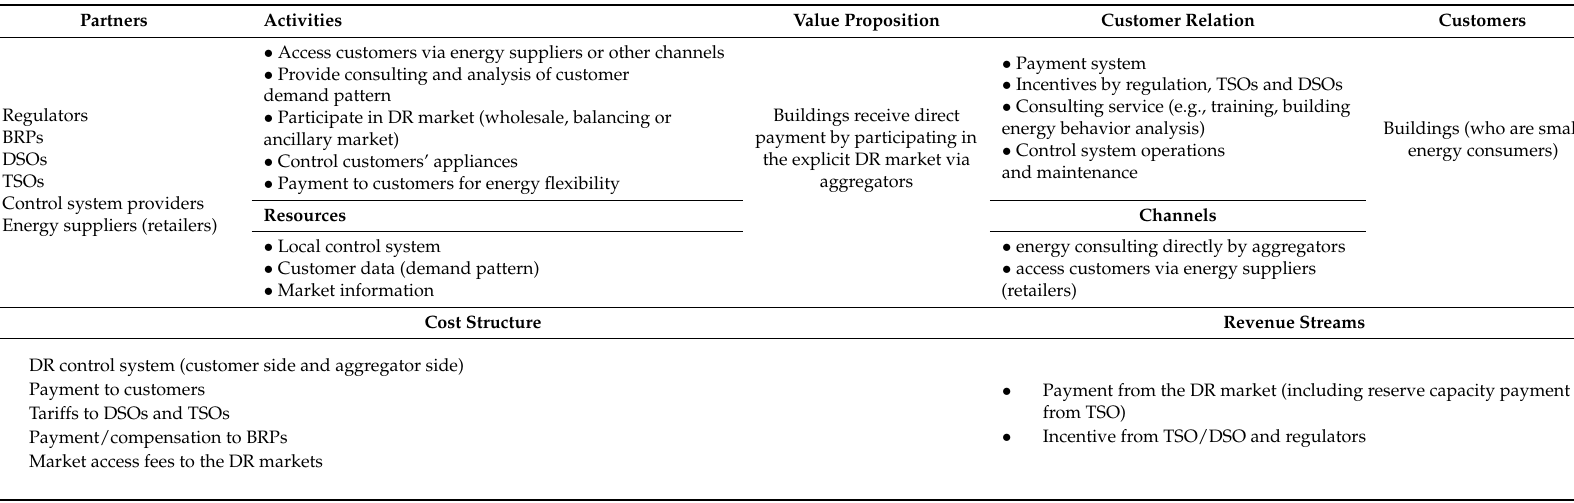
Table 8. Business Model 2—buildings (small energy consumption) participate in the explicit DR via